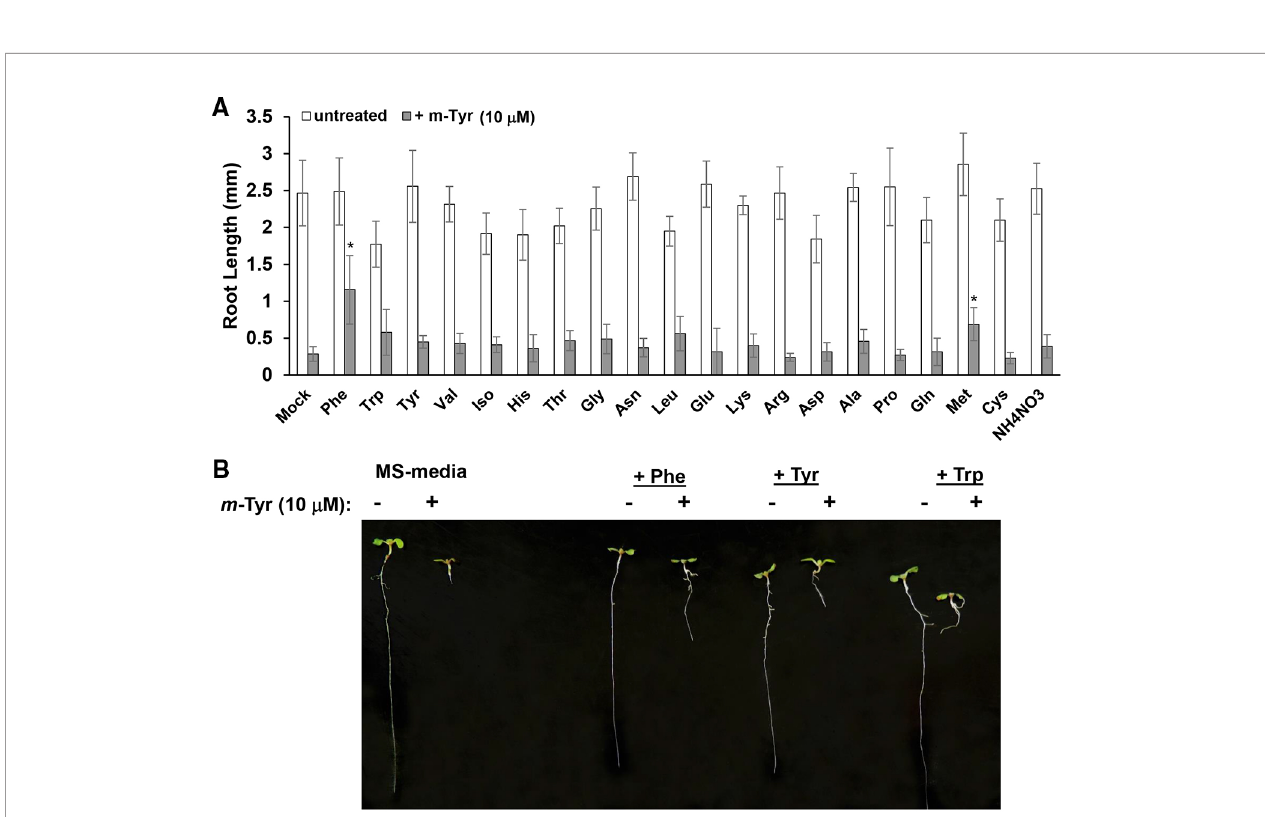
FIGURE 2 | The effect of exogenous amino acids on m -tyrosine mediated toxicity. (A) Five-day-old Arabidopsis seeds were germinated in Murashige and Skoog (MS)-agar plates containing various amino acids (40 m M), in the absence or presence of 10 m M m -tyrosine. (B) Measurements of the root lengths in 5-day-old Arabidopsis seedlings. Bar in (panel A ) represents 1.0 cm. The values are means of three biological replicates with about 25 seedlings in each treatment. Error bars indicate one standard deviation. Asterisks in (panel B ) indicate a signi fi cant difference from 10 m M m -Tyr grown plants (Student's T-test, P ≤